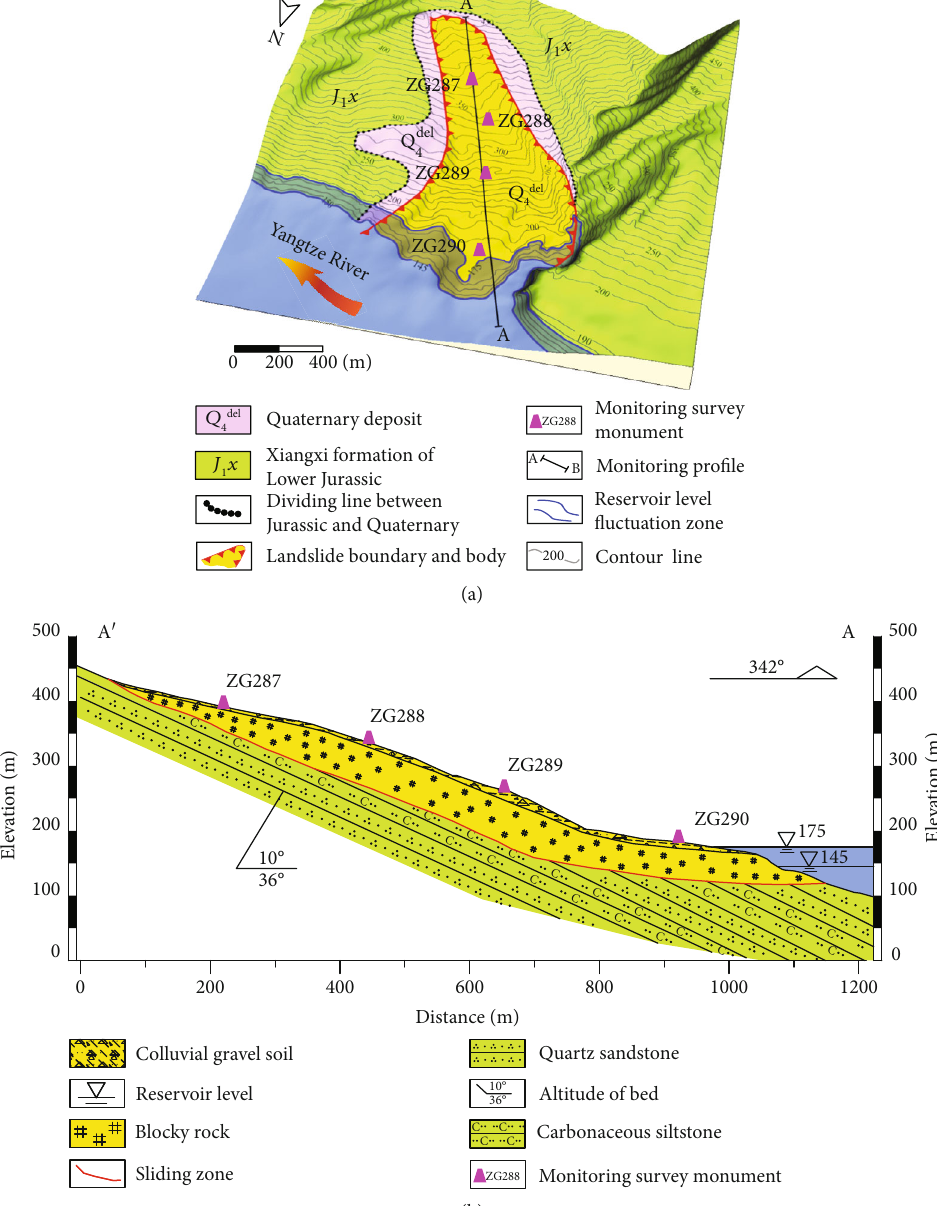
Figure 3: (a) Three-dimensional topographical map of the Tanjiahe landslide and (b) schematic geological cross-section (A – A ′ ) of the Tanjiahe